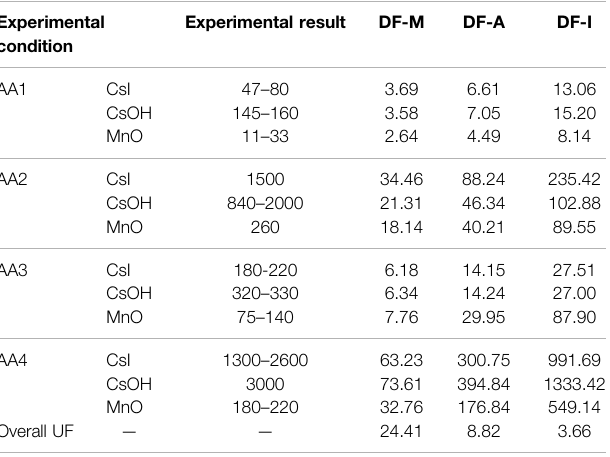
TABLE 2 | Main parameters of ACE test conditions. Parameter